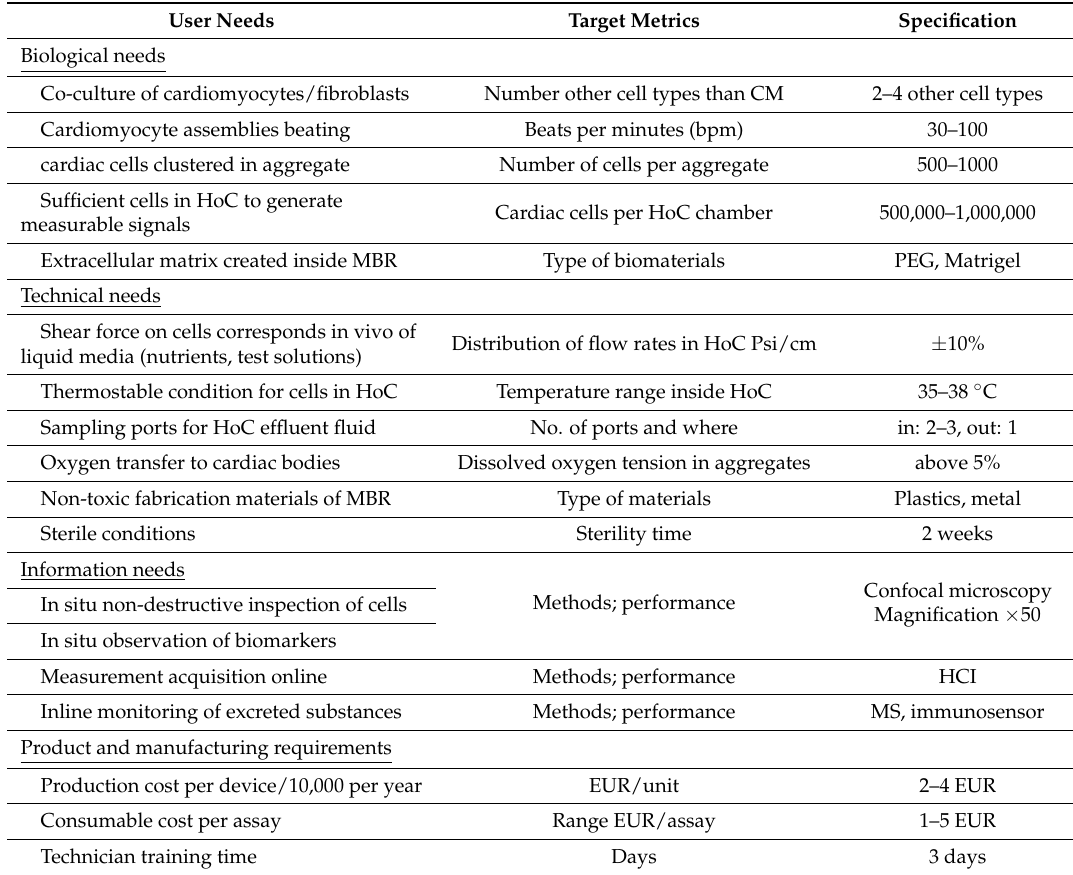
Table 5. User needs of a HoC micro-bioreactor with cardiac cells intended for compound